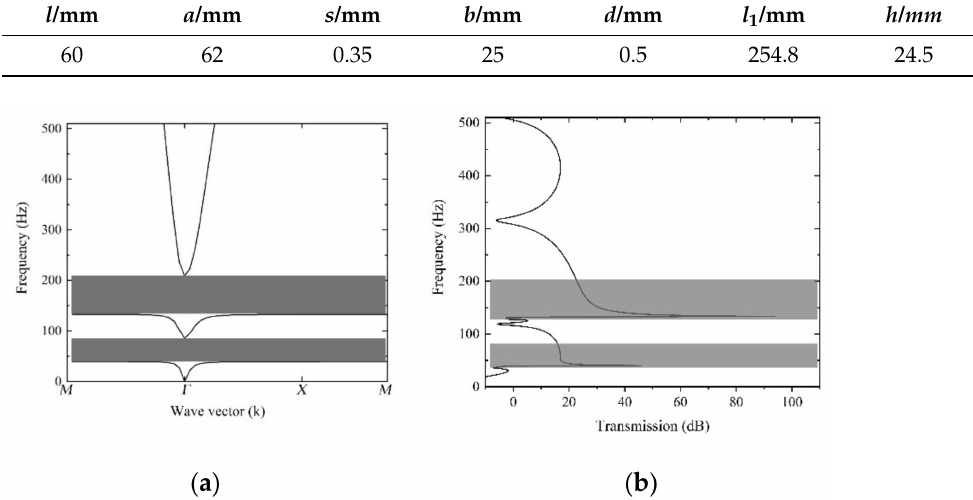
Figure 4. Band diagram ( a ) and transmission spectrum ( b